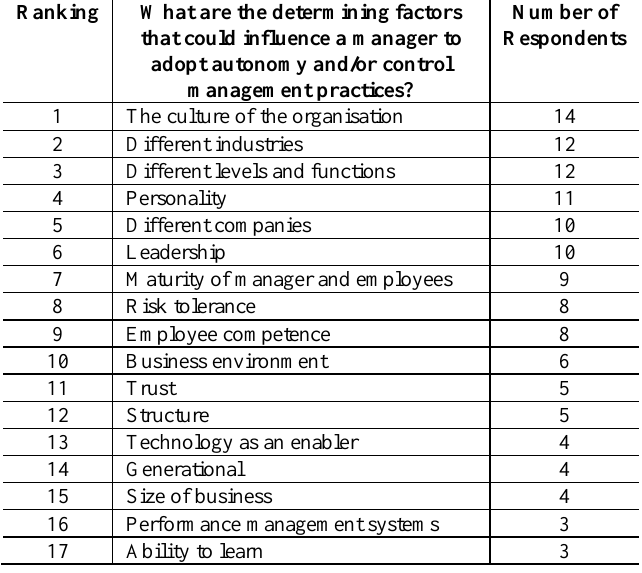
Table 1: Factors influencing the management choice